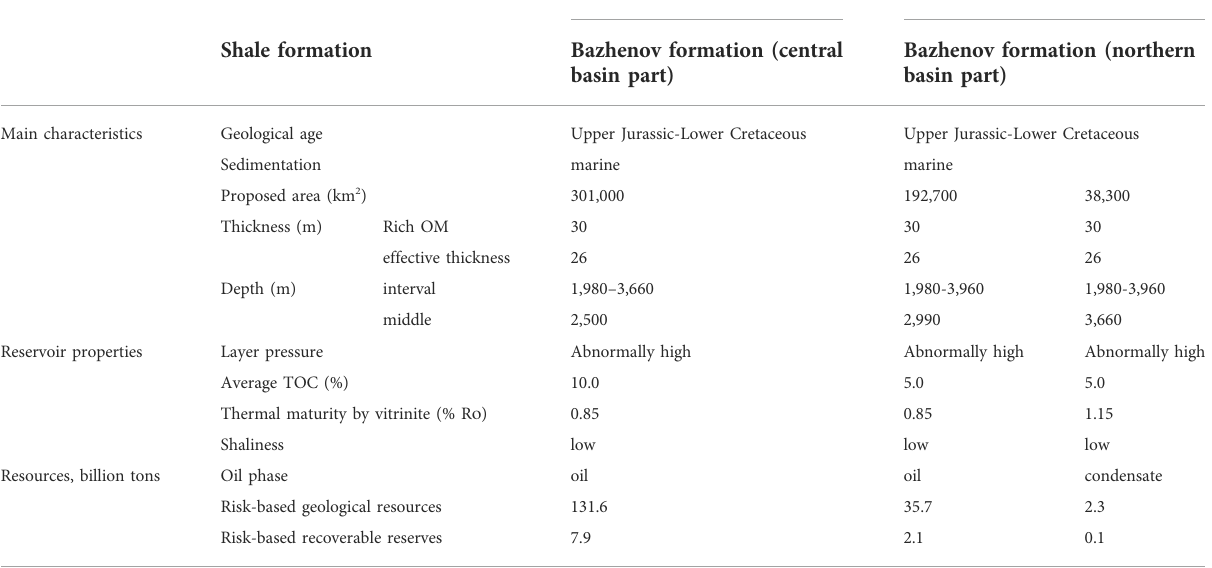
TABLE 1 Oil resources in the Bazhenov formation (EIA,